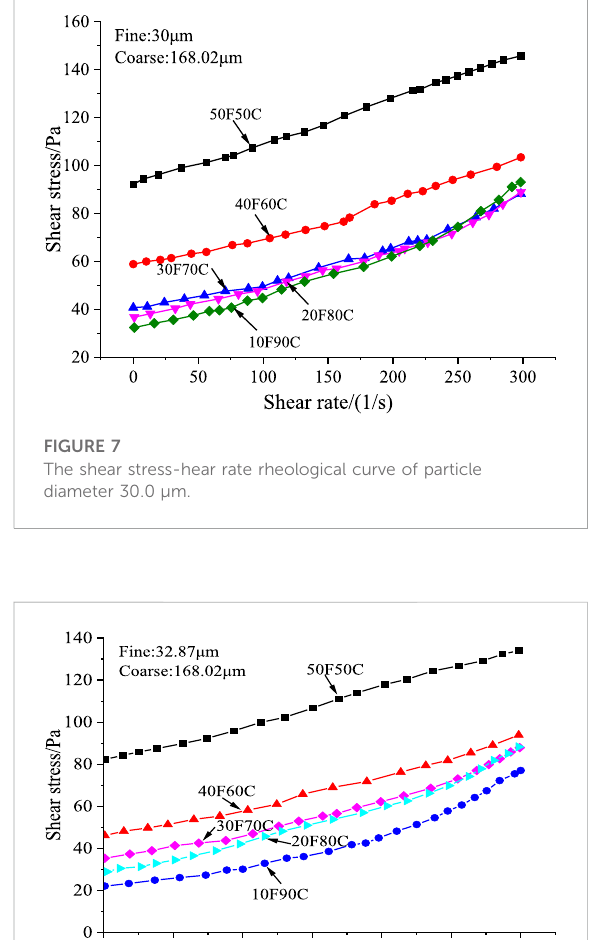
FIGURE 10 The shear stress-shear rate rheological curve of particle diameter 81.28 μ